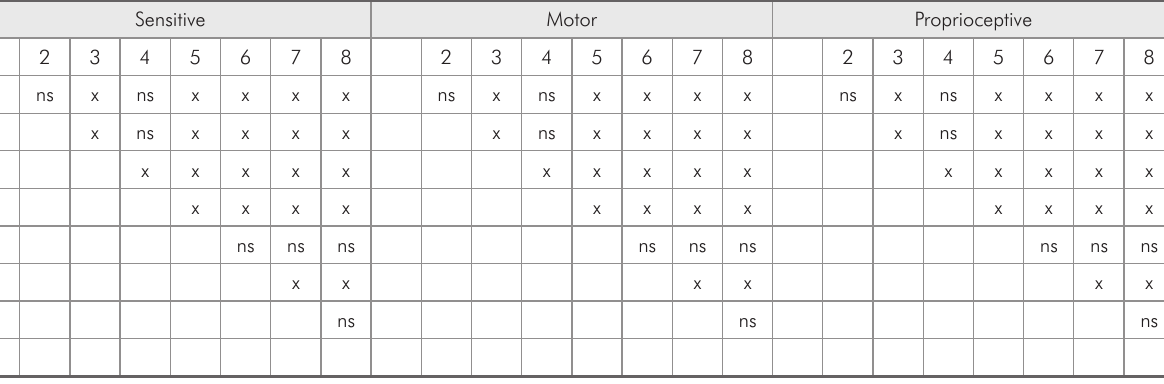
Table 1 - Description of significance.